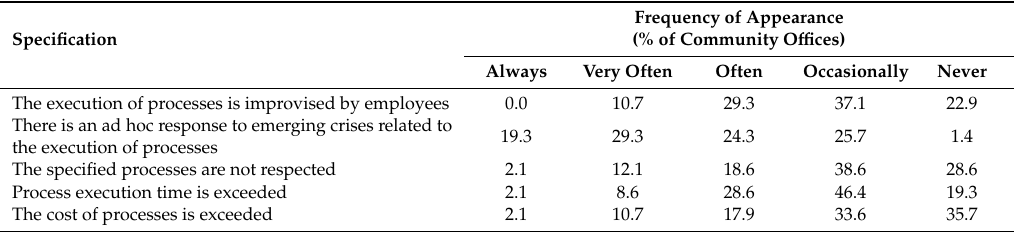
Table 4. Factors showing deviations in the implementation of processes in the surveyed community o ffi ces (n =